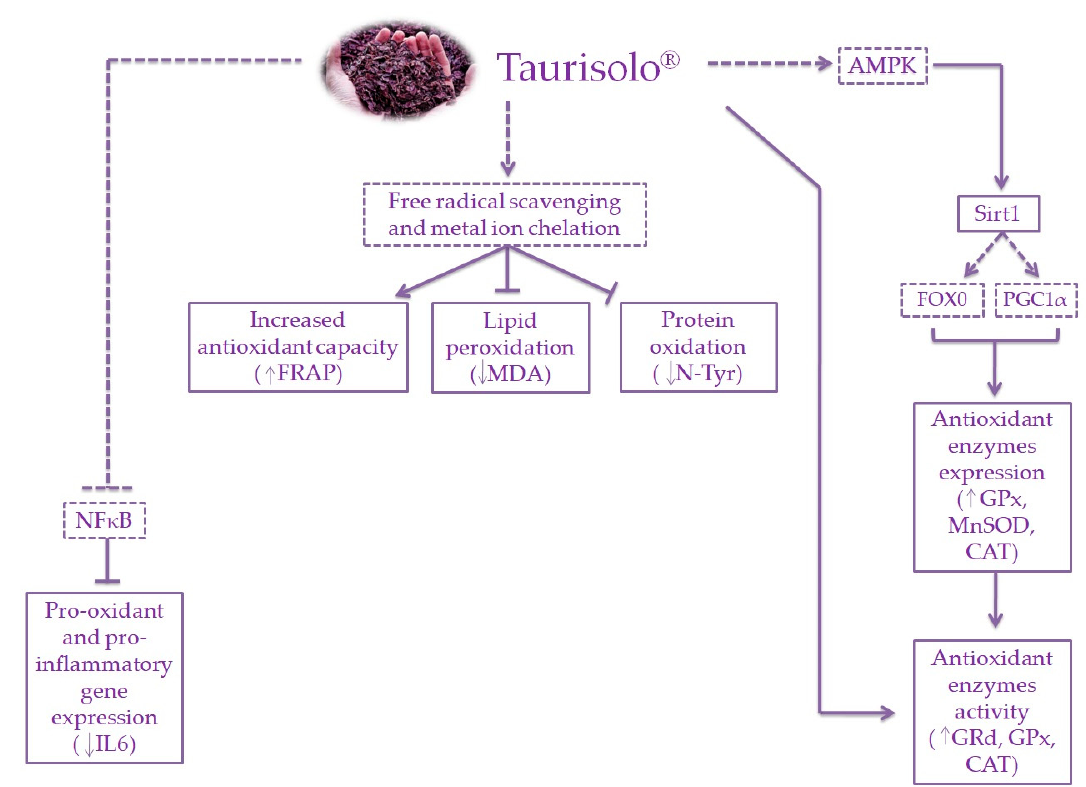
Figure 7. Schematic representation of the potential mechanisms of action of Taurisolo ® —indicates the mechanisms directly observed; —– indicates the mechanisms / pathways not directly observed, but reported in the literature.